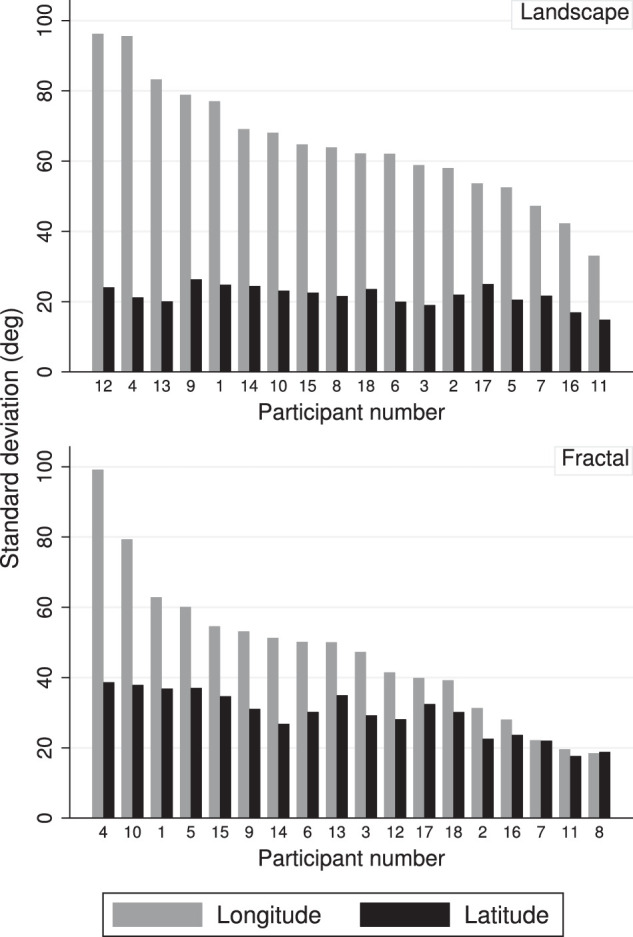
Distribution of gaze spread by participant, for landscapes (top) and fractal scenes (bottom). The graphs show the standard deviations of latitude and longitude for the two scene types, separately for each participant. The bars are ordered by the size of the longitude standard deviation.